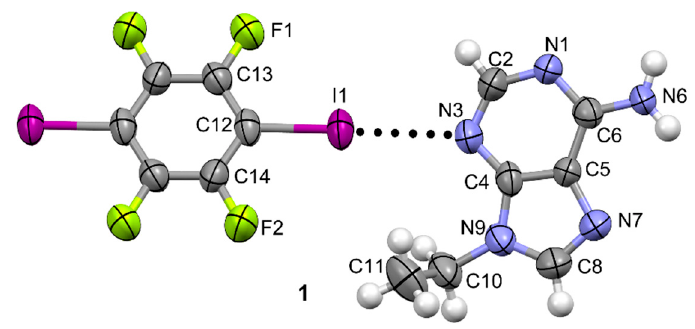
Figure 2. ORTEP plot of the cocrystal 1 with indication of the atom numbering scheme. Ellipsoids drawn at 50% probability level.